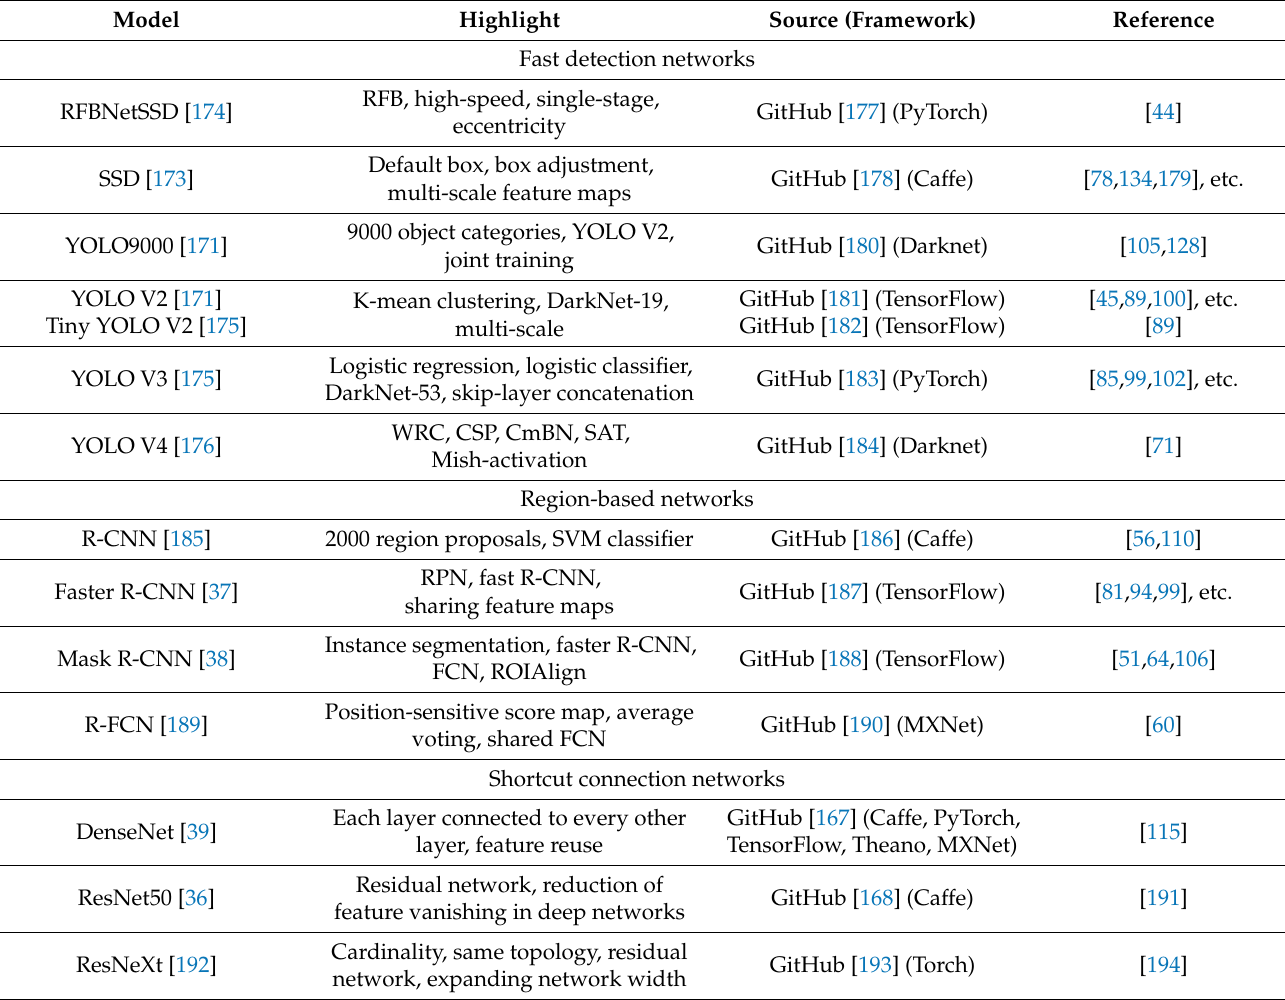
Table 4. Convolutional neural network architectures for object